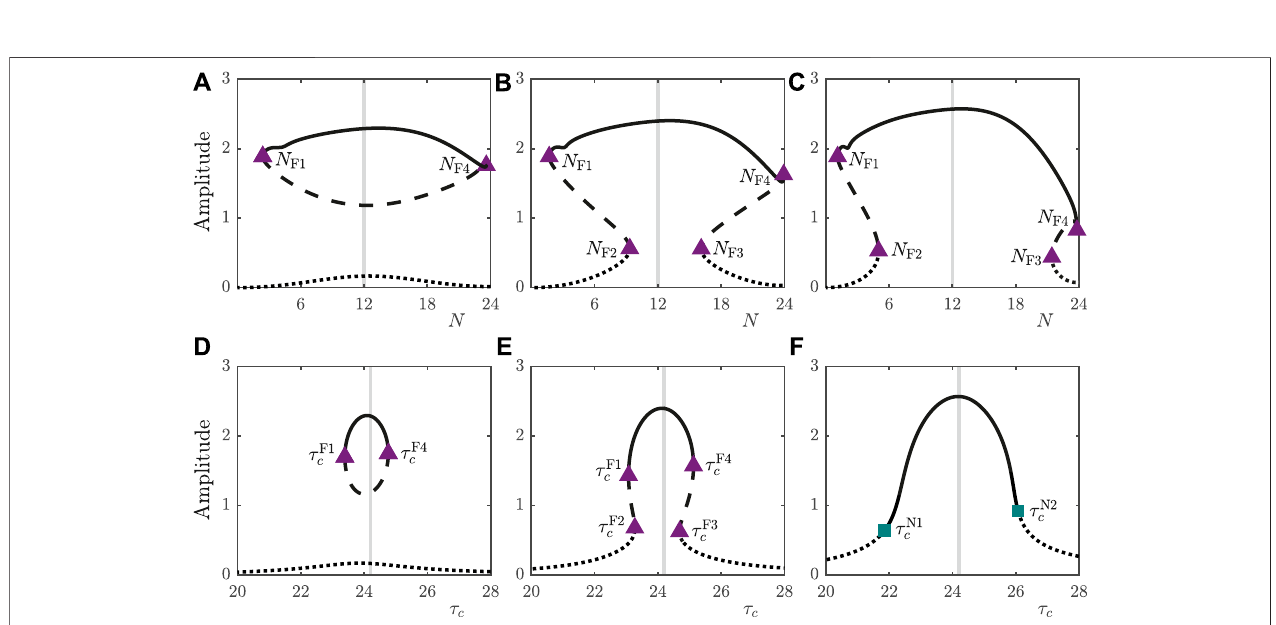
FIGURE 4 | (A – C) : Bifurcation diagrams of the 2D model under variation in N for I (cid:1) 50 [panel (A) ], I (cid:1) 150 [panel (B) ], and I (cid:1) 1000 [panel (C) ]. Depicted are the amplitudes ( L 2 -norm) of the stable (solid), saddle (dashed), and fully unstable (dotted) periodic orbits. The vertical grey lines mark the default parameter value of N (cid:1) 12. (D – F) :Bifurcationdiagramsofthe2Dmodelundervariationin τ c for I (cid:1) 50[panel (D) ], I (cid:1) 150[panel (E) ]and I (cid:1) 1000[panel (F) ].Theverticallinesmark τ c (cid:1) 24 . 2ineach panel. Fold bifurcations are indicated by purple triangles. Neimark – Sacker bifurcations are indicated by teal squares.